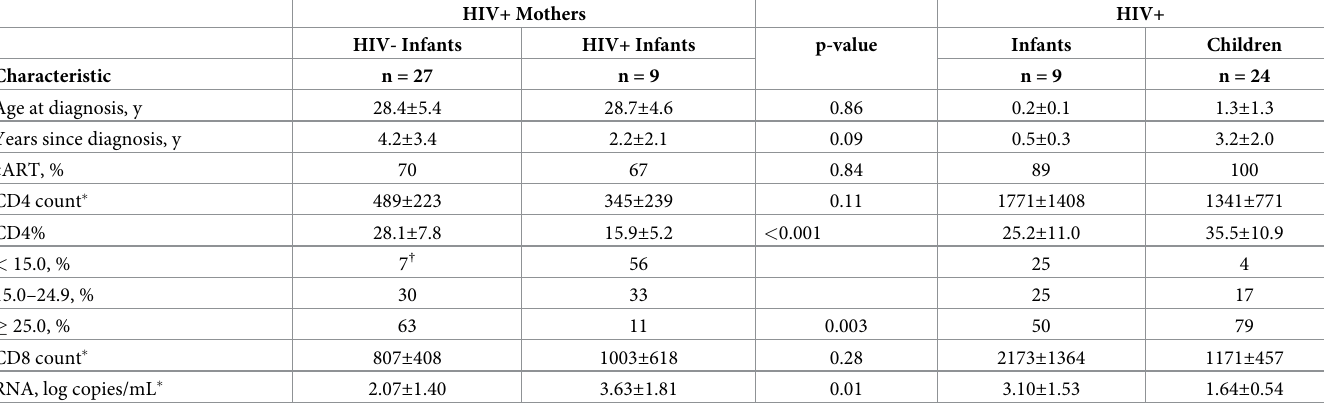
Table 3. Immunological and clinical characteristics of HIV positive mothers, infants, and